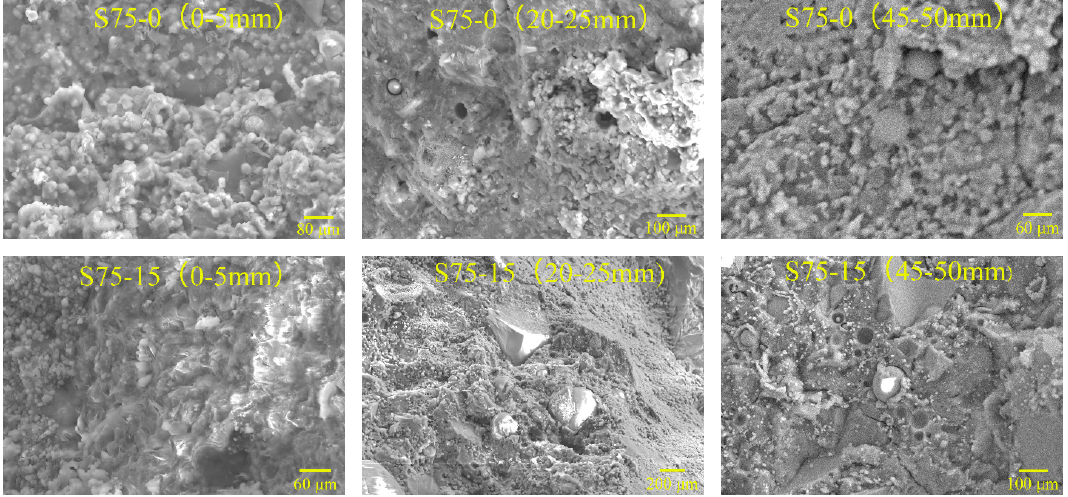
Figure 10. SEM images of RC concretes, after 0, 15, 30, and 60 cycles of sulfate attack (sample location from attack surface: 0–5 mm, 20–25 mm, and 45–50 mm).